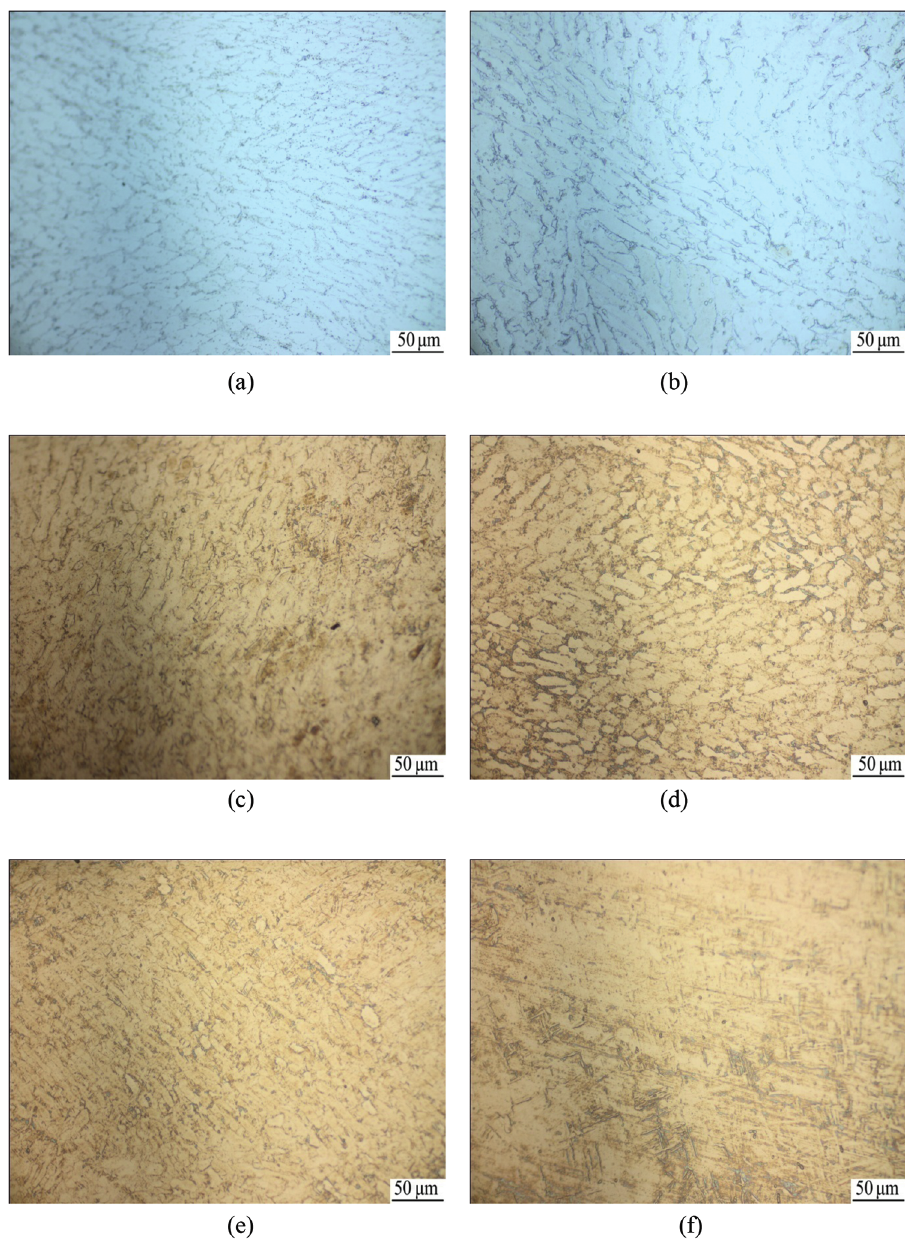
Figure 10 : Optical microstructures of Ti – 6Al – 4V at a fix true strain of 0.9, a fix strain rate of 0.1 s − 1 and different temperatures: (a) 1,023 K, (b) 1,073 K, (c) 1,123 K, (d) 1,173 K, (e) 1,223 K, (f) 1,273 these predictions are validated with microstructural observation made on the deformed specimens. Figure 12 corresponding to 1,023 K and 10 s − 1 shows the micro- structure of flow instability regime. At this deformation condition η -value is about – 0.16, m -value – 0.11 and (cid:1) -value – 0.17. From Figure 12, flow localization band is observed at an angle of about 45° to the compressive axis. Its formation may be bound up with the adiabatic condition generated during a hot deformation and low